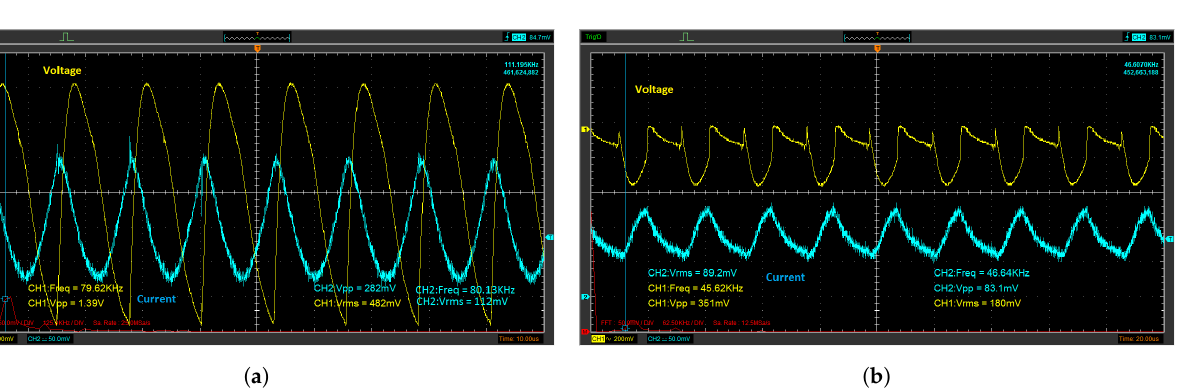
Figure 15. The voltage and current ripple in the DCHN. ( a ) LED lamp. ( b ) CFL